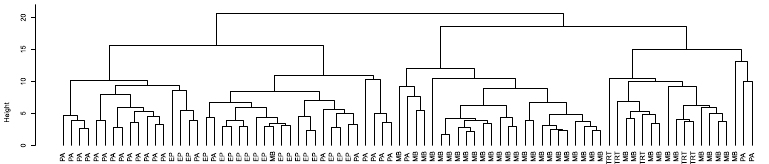
Figure 2. Hierarchical clustering of paediatric cerebellar tumors based on metabolite concentrations. The highest split in the figure separates glial tumors from embryonal tumors. The subsequent split broadly separates